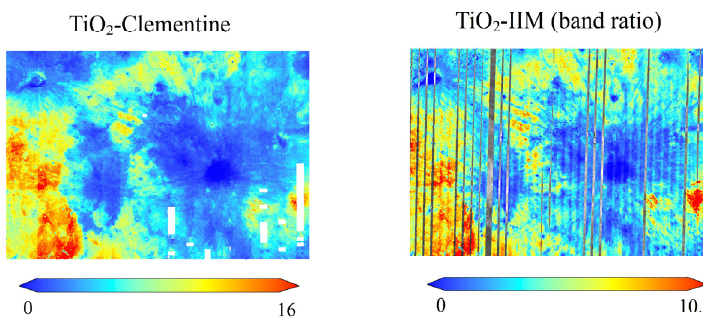
Figure 16. Distribution of TiO 2 based on different data/methods. Table 5. Correlation coefficients based on different data/methods for FeO inversion.